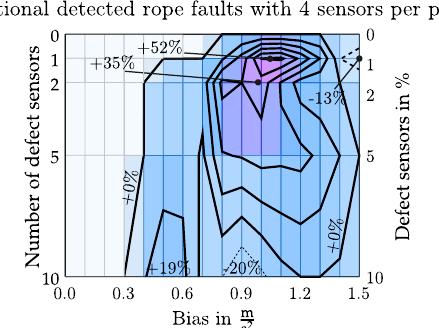
Figure 14. Improvement of fault detection using 4z acceleration sensors with sensor gain